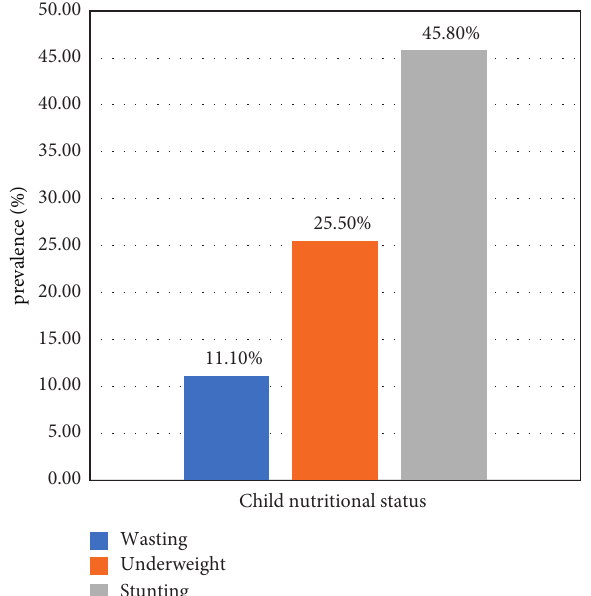
Figure 1: Prevalence of undernutrition among children living in an orphanage in Addis Ababa, Ethiopia, 2020 ( n �